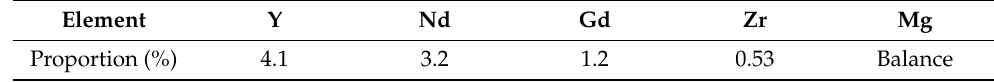
Table 1. The chemical composition of WE43.